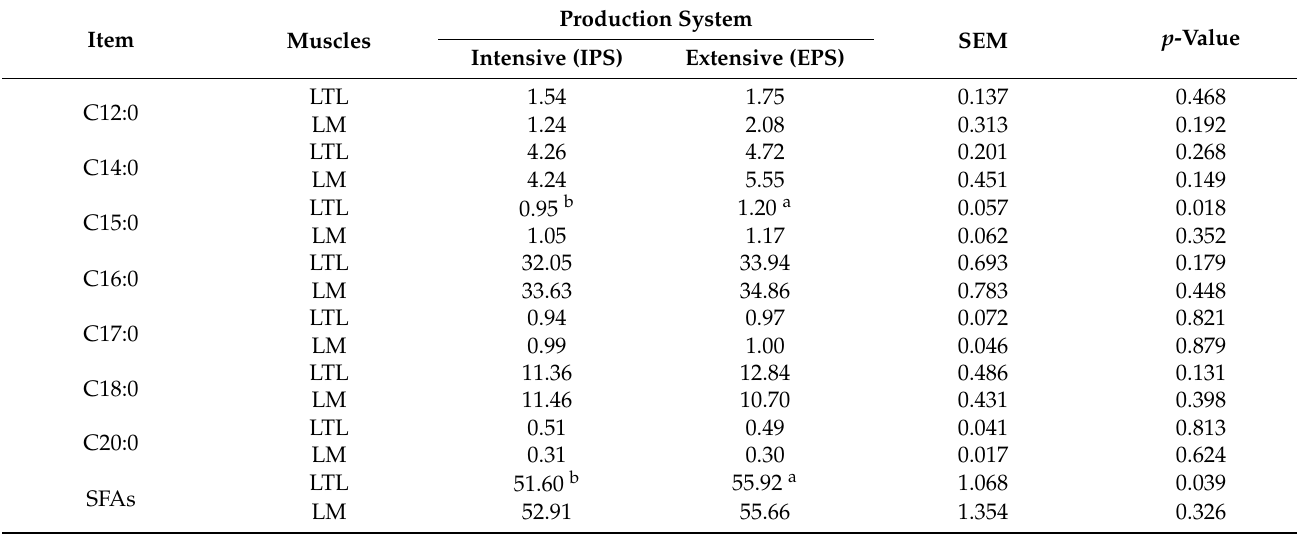
Table 2. Saturated fatty acid profile of intramuscular fat in the Longissimus thoracis et lumborum (LTL) muscle and leg muscles (LM) of New Zealand White